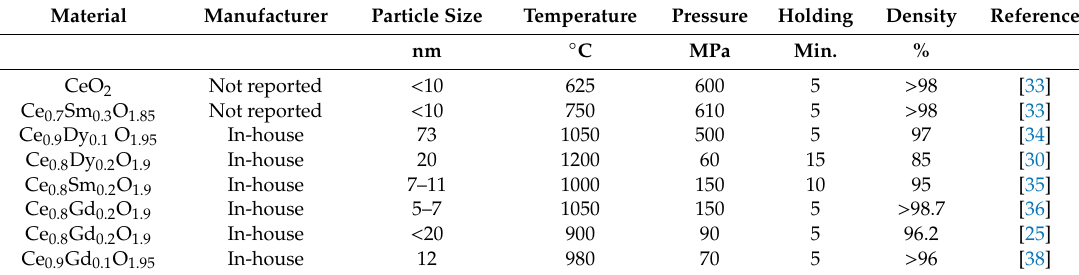
Table 1. Literature survey of Field-Assisted Sintering (FAST / SPS) of undoped and doped ceria. In these works, the authors did not report any crack formation or fragmentation of